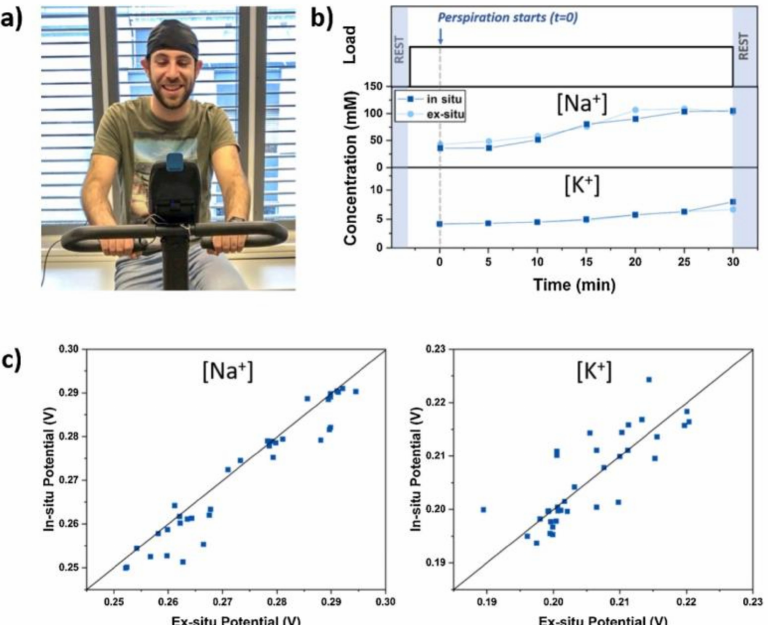
Figure 18. ( a ) Human participants were tested on the wearable platform using this experimental arrangement. ( b ) Thirty minutes after sweating began, the potassium and sodium levels in a volunteer’s sweat were measured using electrolyte analysis. ( c ) Analysis of the sweat of a volunteer after 30 min of indoor cycling to compare in situ and ex situ measures of potassium and sodium. (Reproduced from [405] under common creative License. Copyright 1969, Elsevier, Amsterdam, The